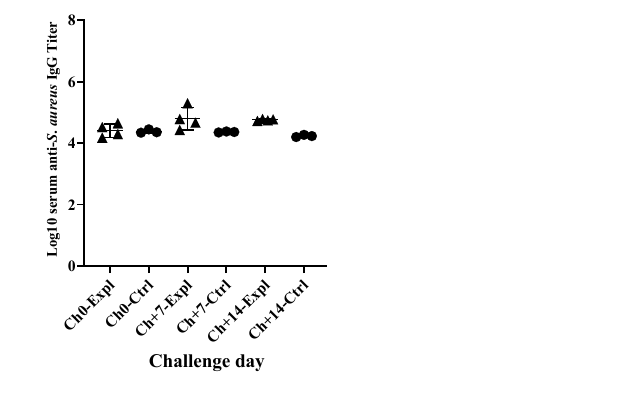
Figure 5. Serum anti- S. aureus IgG titers of experimental (Expl: ▲ ) and control (Ctrl: ● ) cows at days 0, 7 and 14 of challenge. No significant difference between experimental and control groups.